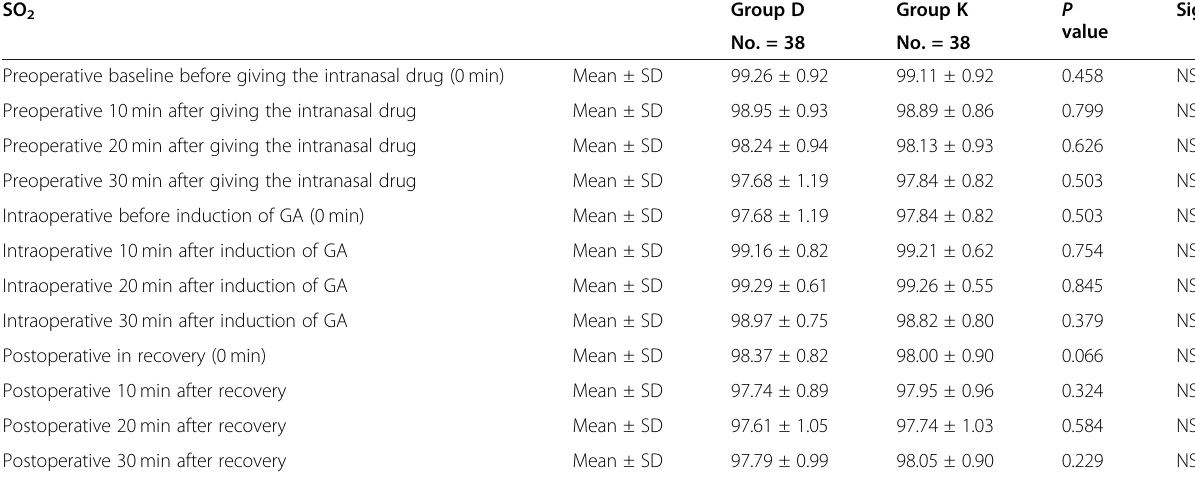
Table 9 Comparison between group D and group K as regards arterial oxygen saturation SO